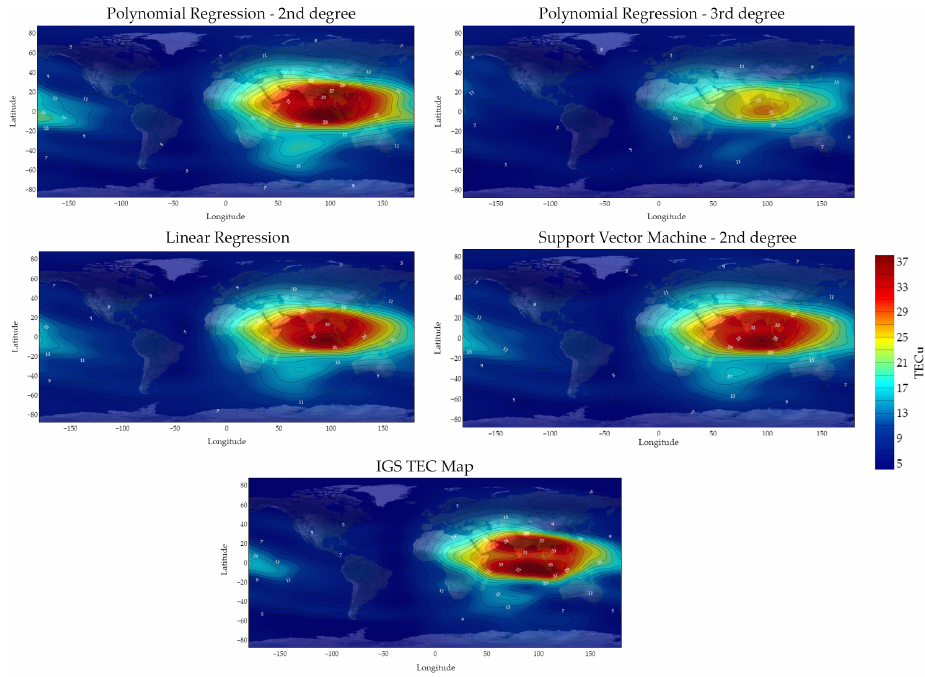
Figure 14. Candidate regression models TEC Map and correspondent IGS Map. Reconstruction made for 20 March 2019 at 08:00 UTC.